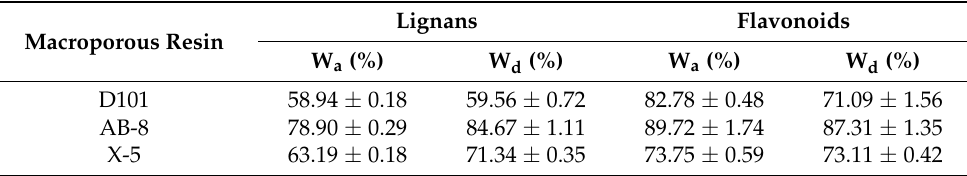
Table 1. Results of static adsorption and desorption experiments with V. amurensis extract.